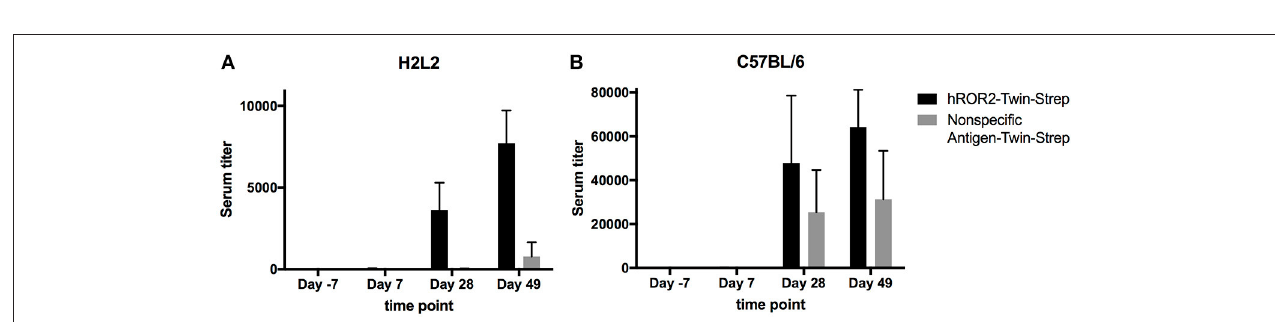
FIGURE 1 | Graphic representation of the discovery strategy for novel, fully human mAbs and functional ADCs from immune libraries of Ig transgenic mice. H2L2 Ig transgenic mice (Harbor BioMed) capable of generating antibodies with completely human V H and V L regions were immunized with soluble human ROR2-ECD-Twin-Strep. Transpo-mAb compatible libraries were generated from MACS-enriched antigen-specific splenocytes and co-electroporated into L11 mouse pro-B cells (with a RAG2-knock-out background) employing Piggy-Bac transposase to allow for stable integration. Cell clones expressing antigen-specific antibodies were single-cell sorted by FACS. Supernatants of these single-cell clones were directly screened for antigen-binding by ELISA and their suitability as an ADC by a secondary, functional ADC-based cell killing assay. Potent ADC candidates were subjected to sequence recovery of variable domain coding regions by RT-PCR and validated following expression of the antibodies in HEK293T cells.